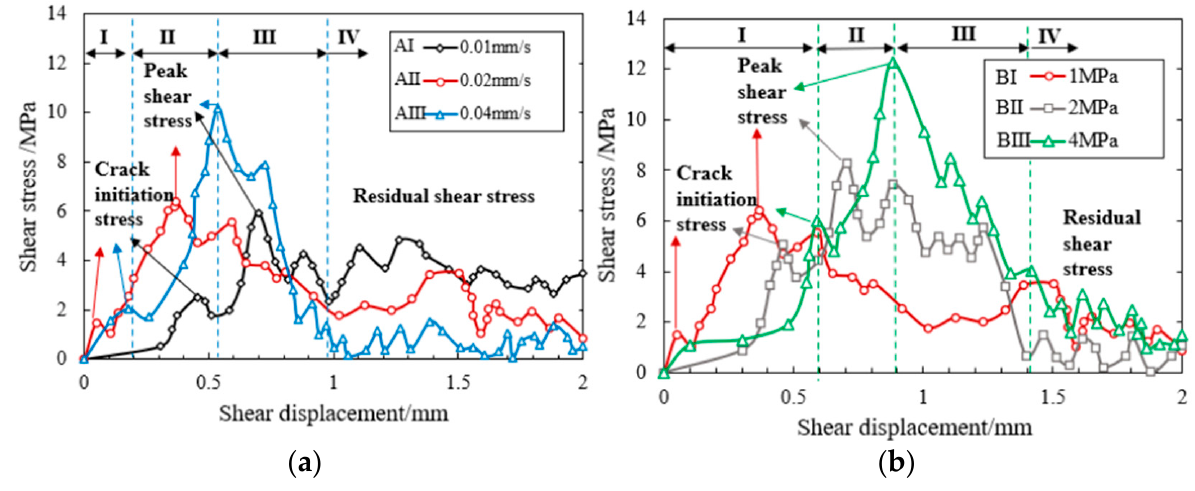
Figure 8. Shear stress–shear displacement curves: ( a ) case A; and ( b ) case B.